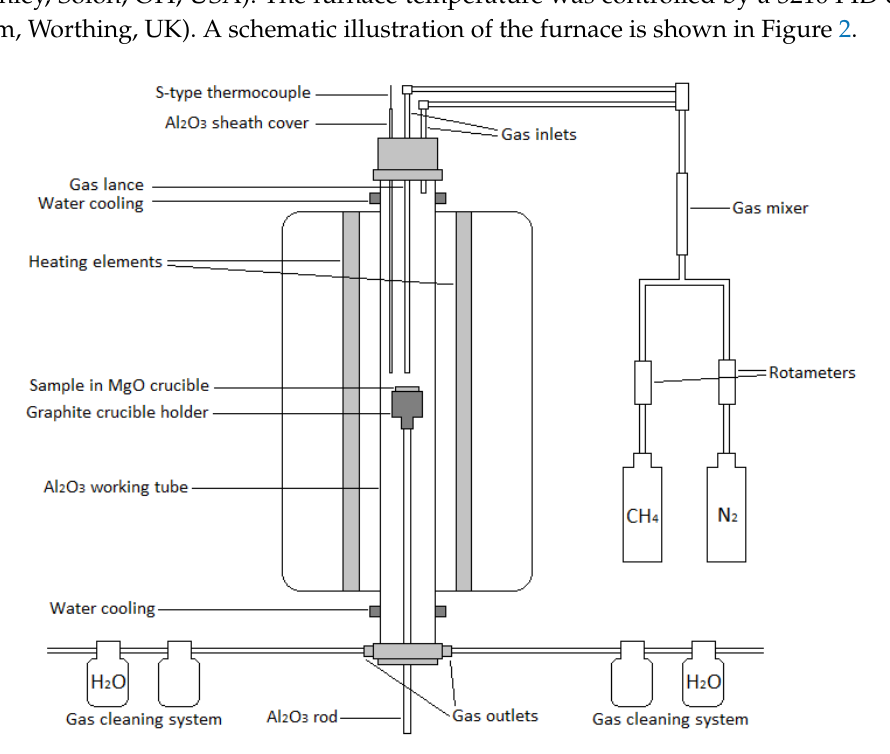
Figure 2. Schematic of the furnace (not to scale).